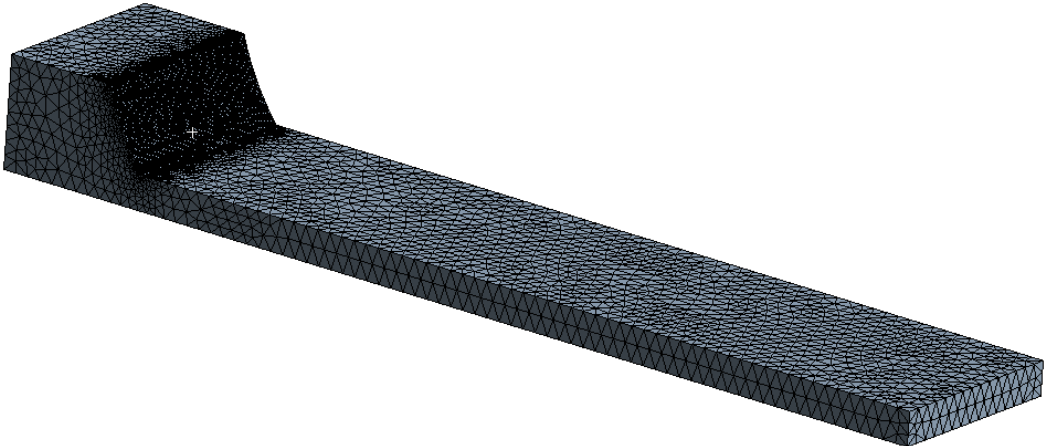
Figure 5. Finite element model of fluid domain in middle gate chamber and corresponding middle gate section.